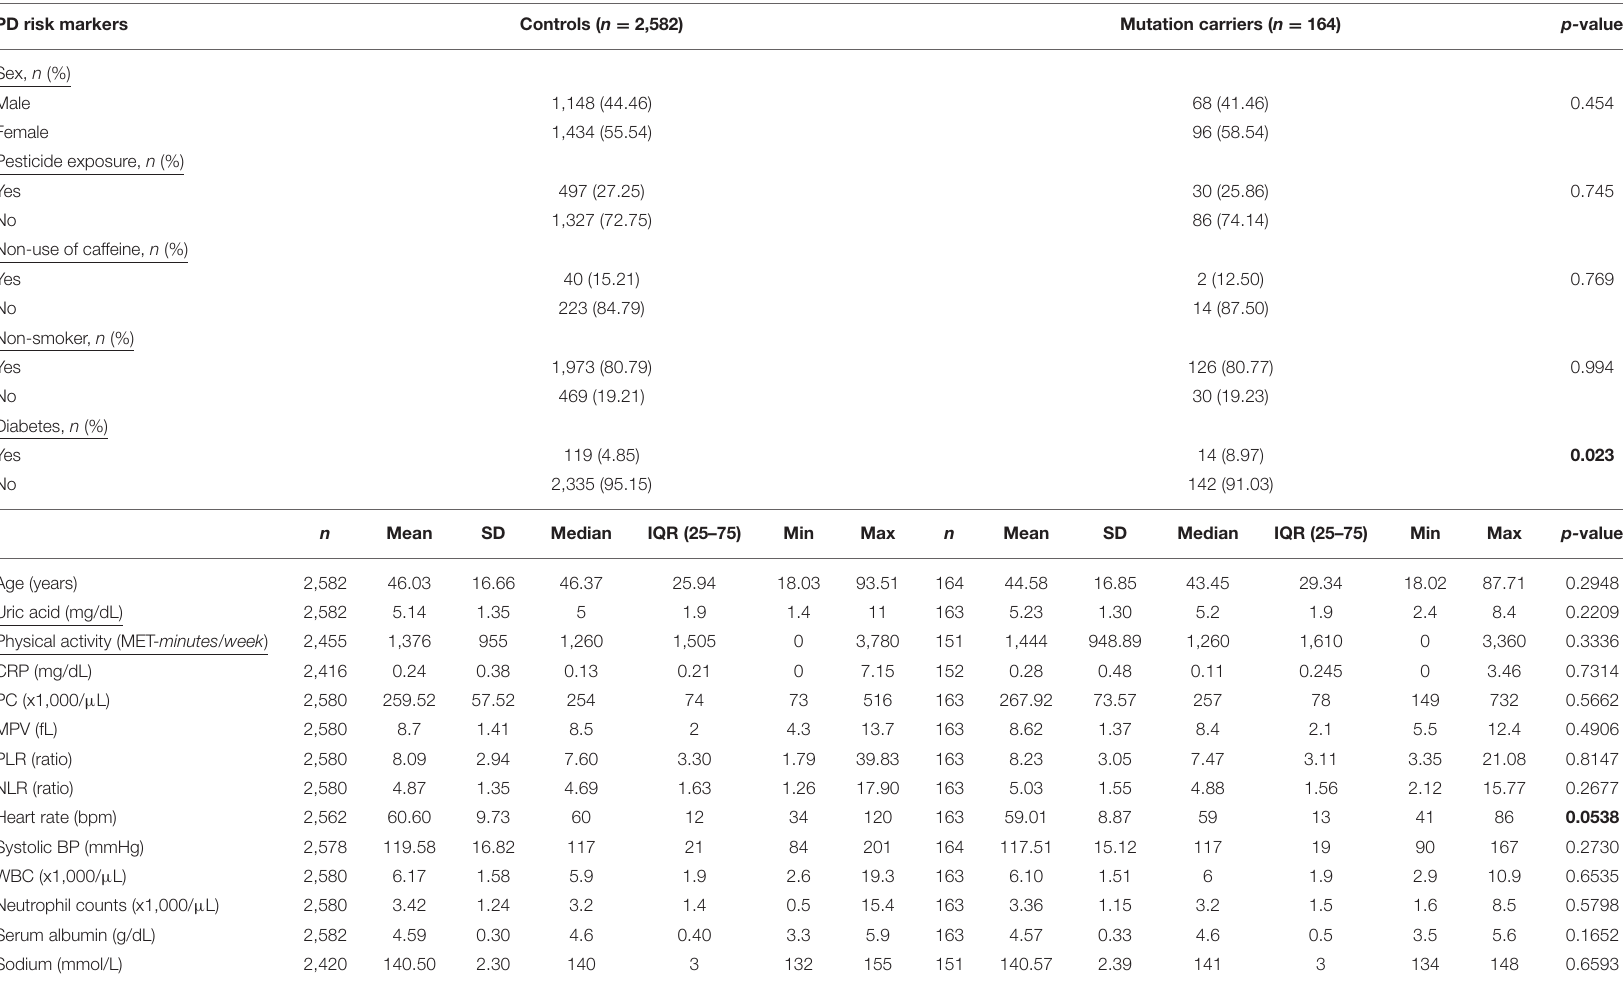
TABLE 2 | Descriptive statistics of PD risk markers in heterozygous PRKN mutation carriers in the exome sequenced dataset of the CHRIS study. PD risk markers Controls ( n = 2,582) Mutation carriers ( n = 164) p-